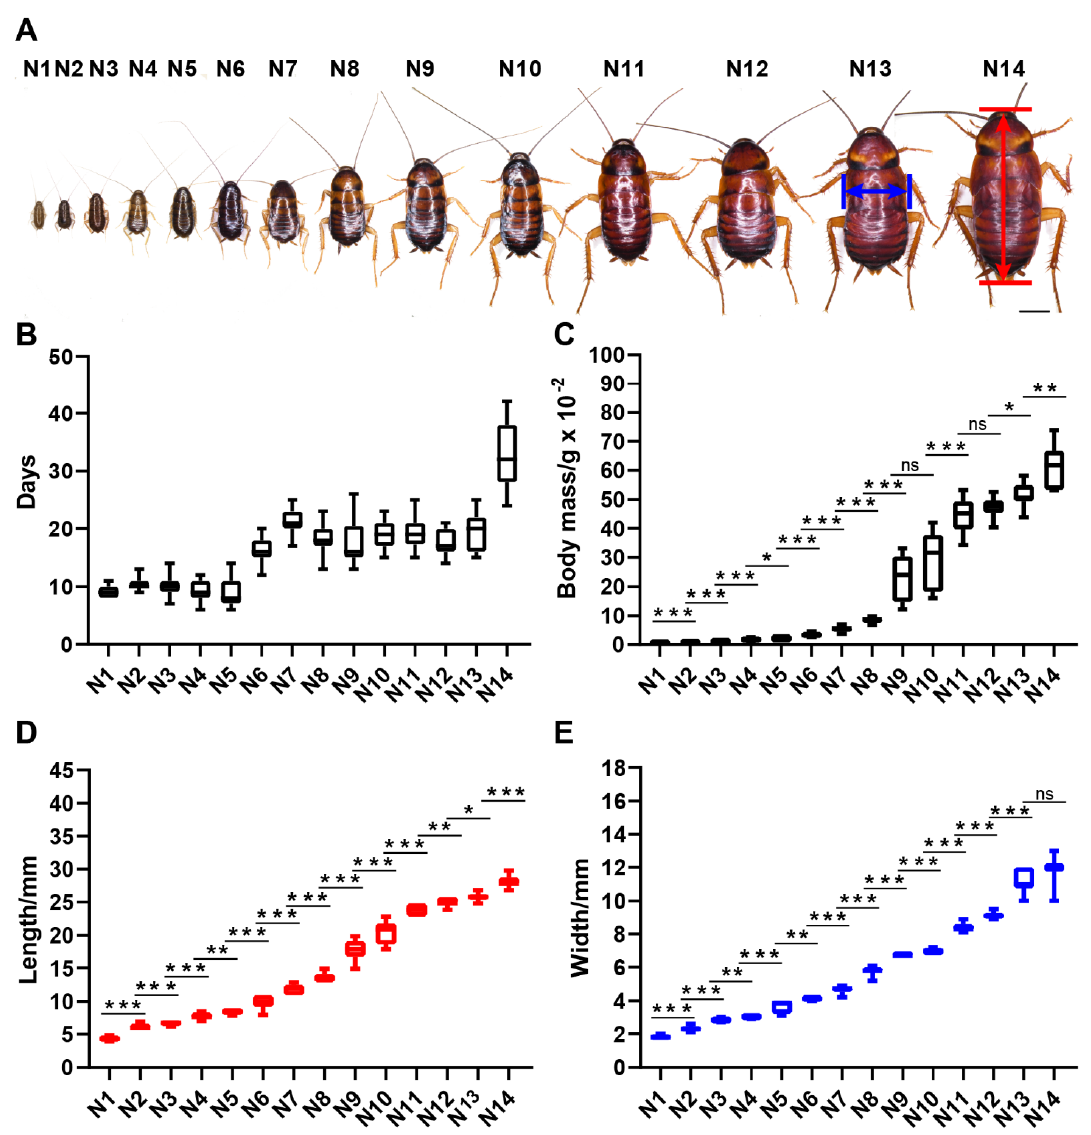
Figure 5. Nymphal development of P. americana . ( A ) Overview of the 14 nymphal instars. First-instar nymph: N1; Second-instar nymph: N2; Third-instar nymph: N3; Fourth-instar nymph: N4; Fifth-instar nymph: N5; Sixth-instar nymph: N6; Seventh-instar nymph: N7; Eighth-instar nymph: N8; Ninth-instar nymph: N9; Tenth-instar nymph: N10; Eleventh-instar nymph: N11; Twelfth-instar nymph: N12; Thirteenth-instar nymph: N13; Fourteenth-instar nymph: N14. Scale bars: 5000 μ m. ( B ) The instars of the 14 nymphal instars. ( C ) The body mass of the 14 nymphal instars. ( D ) The body length of the 14 nymphal instars. ( E ) The body width of the 14 nymphal instars. ns, not signif- icant or p > 0.05 between the two nymphal instars; * p < 0.05; ** p < 0.01; *** p < 0.001.